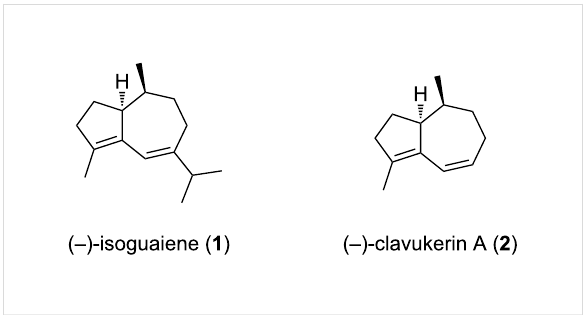
Figure 1: Structures of the sesquiterpene ( − )-isoguaiene ( 1 ) and the trisnorsesquiterpene clavukerin A ( 2